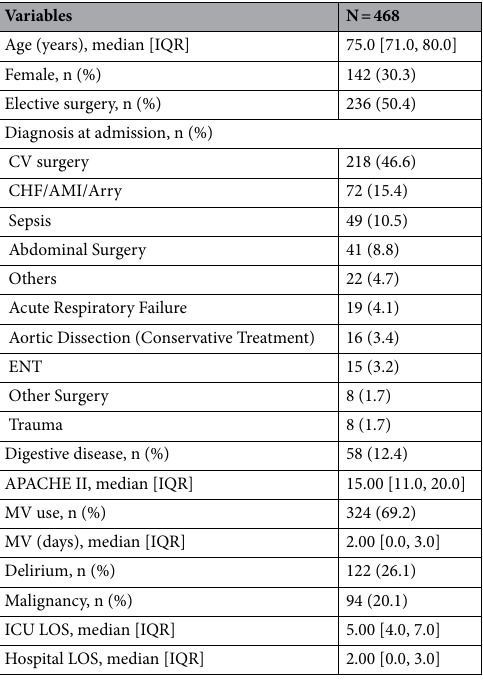
Table 1. The main characteristics data of the study. IQR, interquartile range; CV, cardiovascular; CHF/AMI/ Arrhy, congestive heart failure/acute myocardial infarction/arrhythmia; ENT, ear nose throat; APACHE II, Acute Physiology and Chronic Health Evaluation II; MV, mechanical ventilation; ICU, intensive care unit; LOS, length of stay.